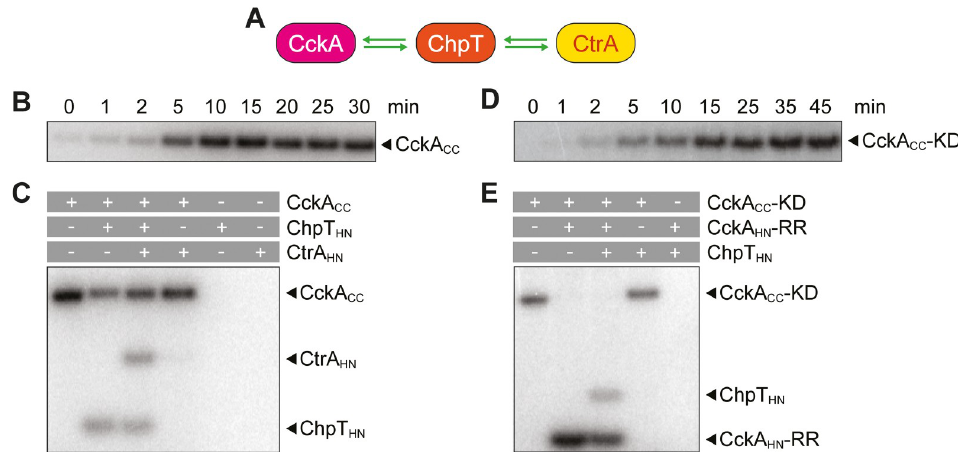
Fig 7. The connectivity within the CckA-ChpT-CckA phosphorelay is conserved in H . neptunium . (A) Scheme of the CckA-ChpT-CtrA phosphorelay. Green arrows indicate phosphotransfer. (B) Autophosphorylation of CckA CC upon incubation with [ γ 32 P]-ATP. Samples were taken at the indicated time points after the start of the reaction and analyzed by SDS-PAGE prior to detection of radioactivity by phosphor imaging. (C) In vitro phosphotransfer from ChpT HN to CtrA HN with CckA CC as a phosphoryl donor. After autophosphorylation of CckA CC for 30 min, the indicated proteins (marked with pluses) were mixed and incubated for 5 min. After termination of the reactions by addition of SDS sample buffer, the mixtures were separated by SDS-PAGE and radioactivity was detected by phosphor imaging. (D) Autophosphorylation of CckA-KD CC upon incubation with [ γ 32 P]-ATP. Samples were taken at the indicated time points and analyzed by SDS-PAGE prior to detection of radioactivity by phosphor imaging. (E) In vitro phosphotransfer from CckA-RR HN to ChpT HN with CckA-KD CC as a phosphoryl donor. After autophosphorylation of CckA-KD CC for 45 min, the indicated proteins (marked with pluses) were mixed and incubated for 5 min. The reaction was terminated by addition of SDS sample buffer, and the mixtures were separated by SDS-PAGE prior to detection of radioactivity by phosphor